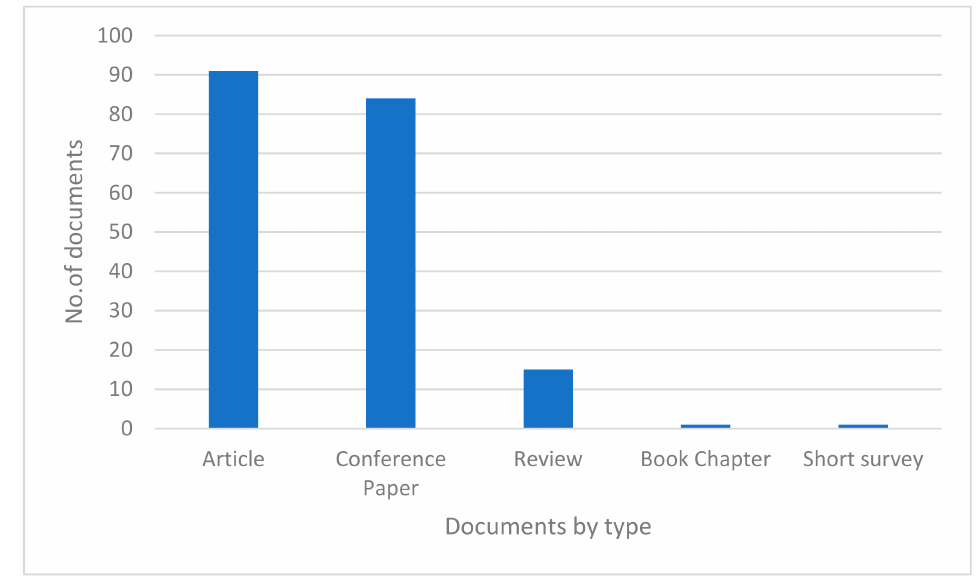
Figure 2. Documents by